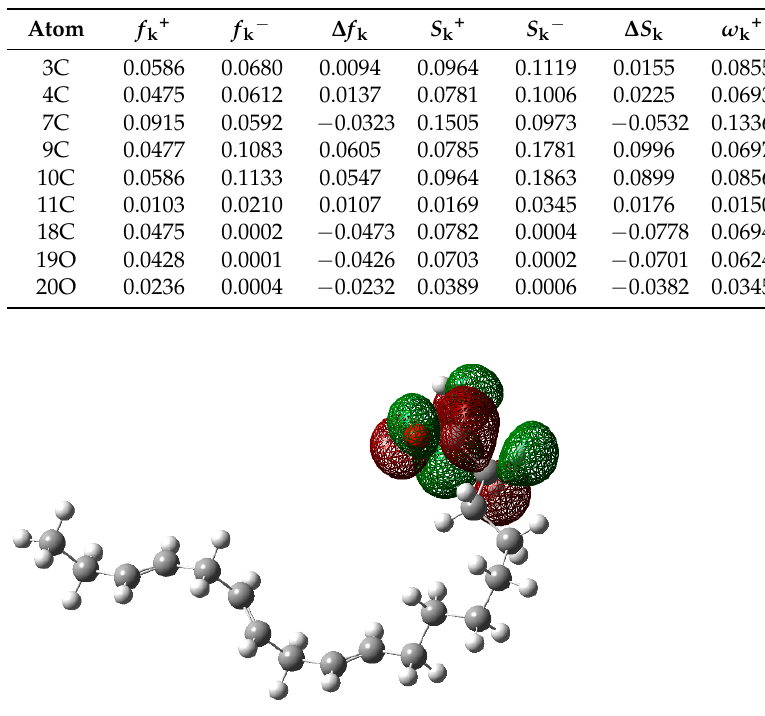
Figure 10. The lowest unoccupied molecular orbital (LUMO) of α -linoleic acid in the aqueous phase.